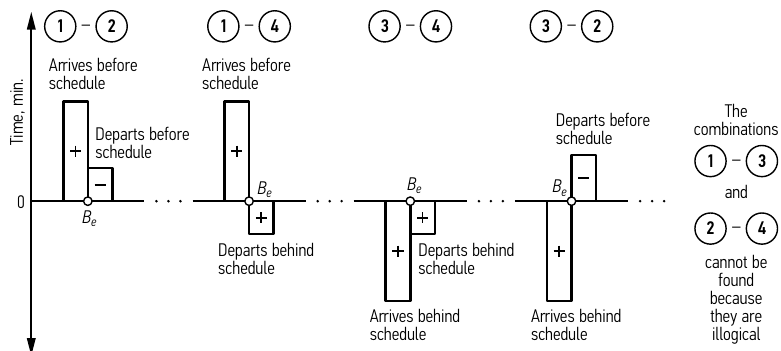
Fig. 3. The combinations of passenger train’s arrival (departure) at the intermediate station B before (behind) schedule